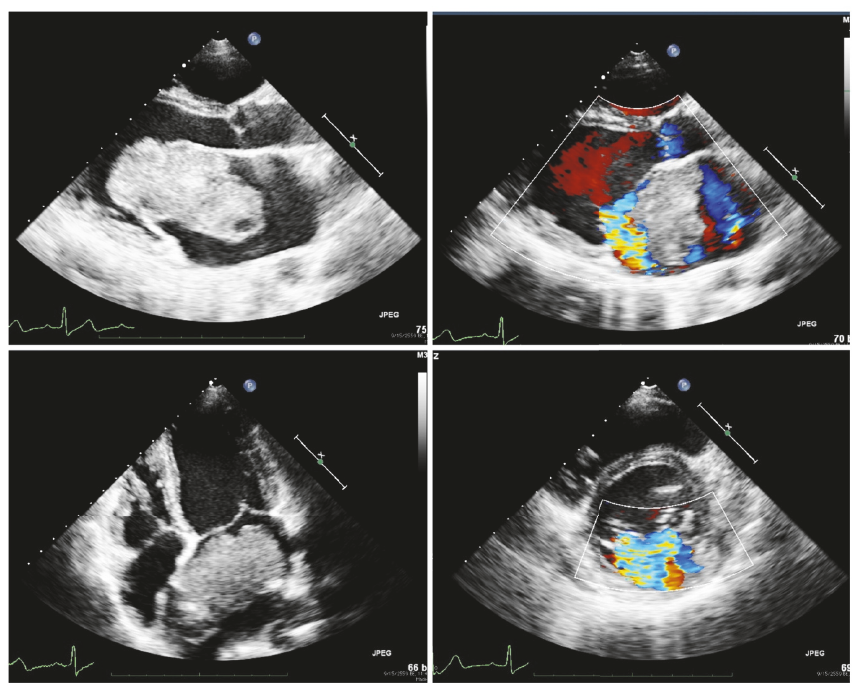
Figure 1: Preoperative echocardiography showed huge left atrial mass protruding through mitral valve with severe mitral